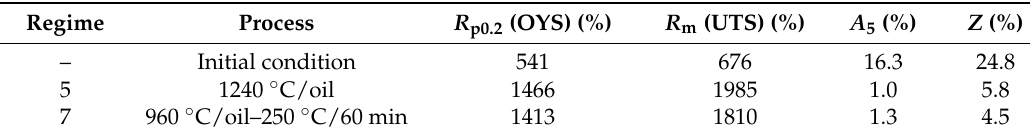
Table 5. Micro-tensile test data for selected regimes.